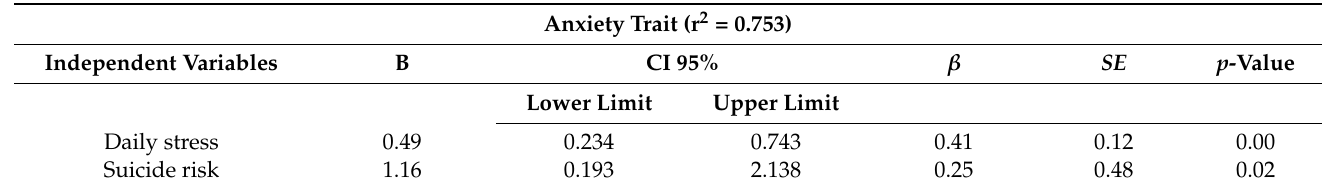
Table 5. Cont. Anxiety Trait (r 2 =